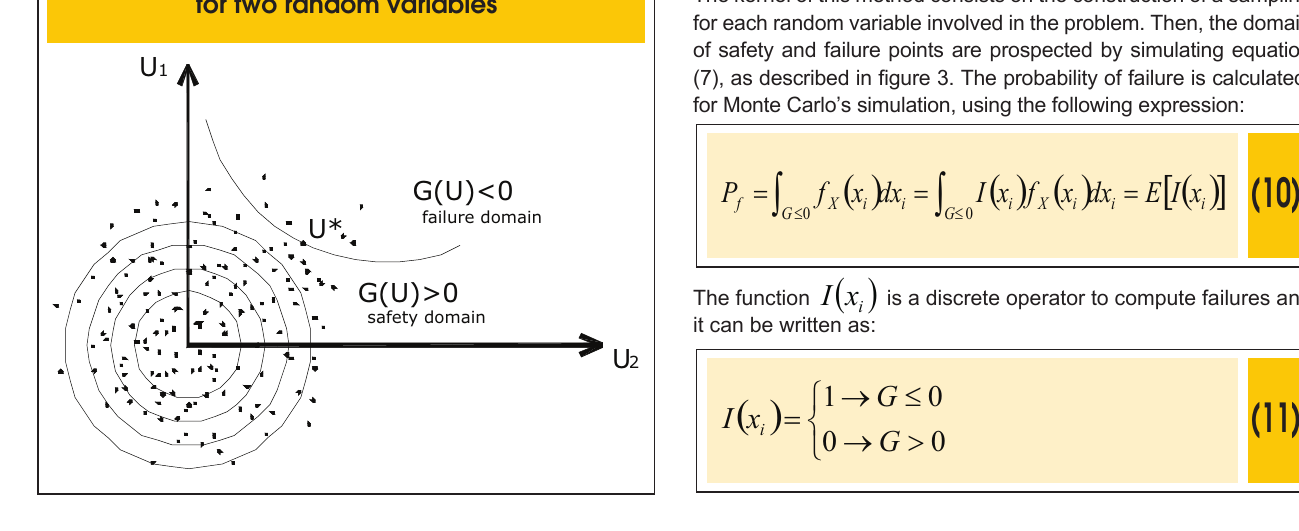
Figure 3 – Monte Carlo's sampling for two random variables